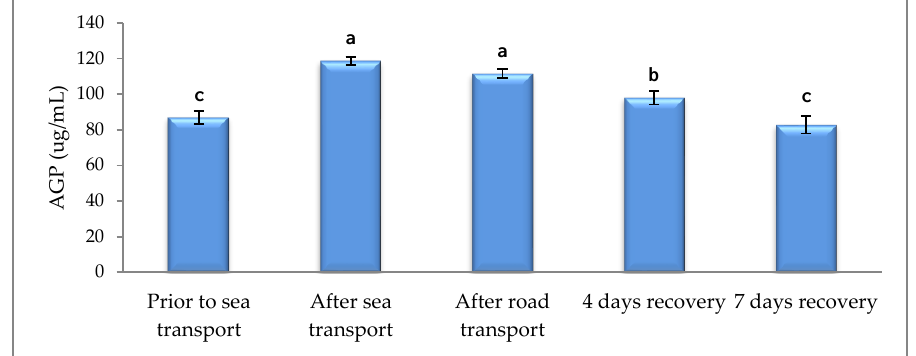
Figure 2. Effects of sea and road transport on serum α -1 glycoprotein (AGP) levels in cattle. The number of animals used in each sampling point was 24 heifers. Means with different letters are significantly different at p < 0.05. Animals 2018 , 8 , x